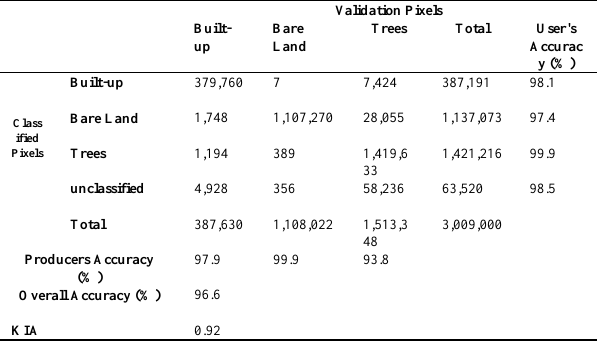
Table 2. Confusion matrix of classified pixels.